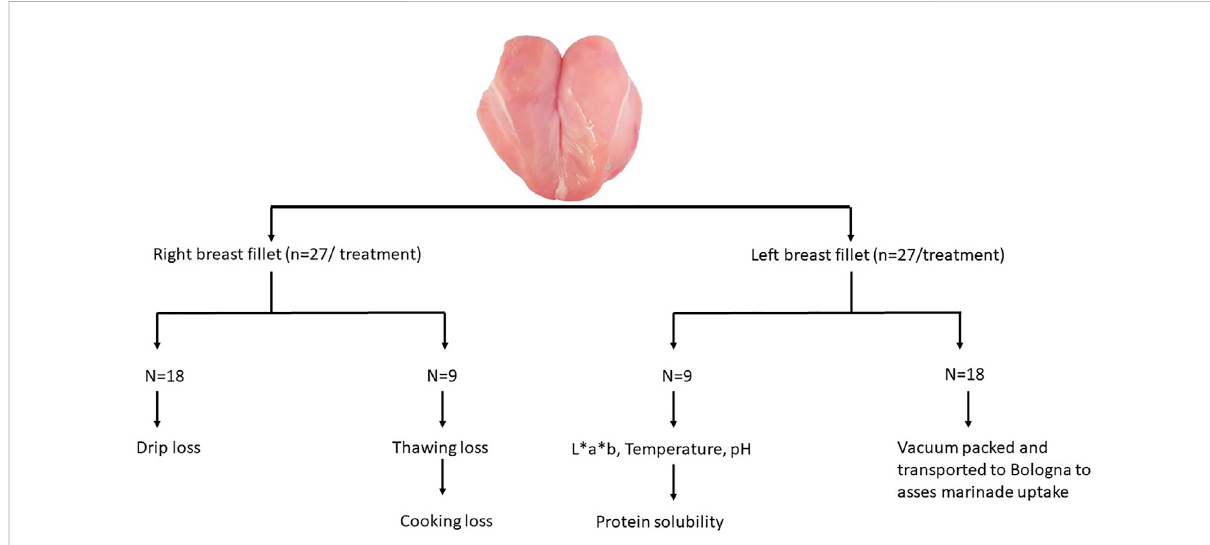
FIGURE 2 Overview of meat quality parameters determined on left and right breast fi